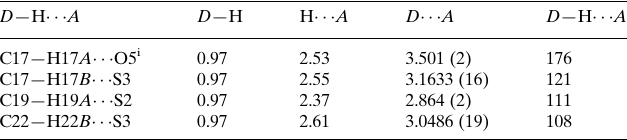
Hydrogen-bond geometry (A˚ , (cid:2)